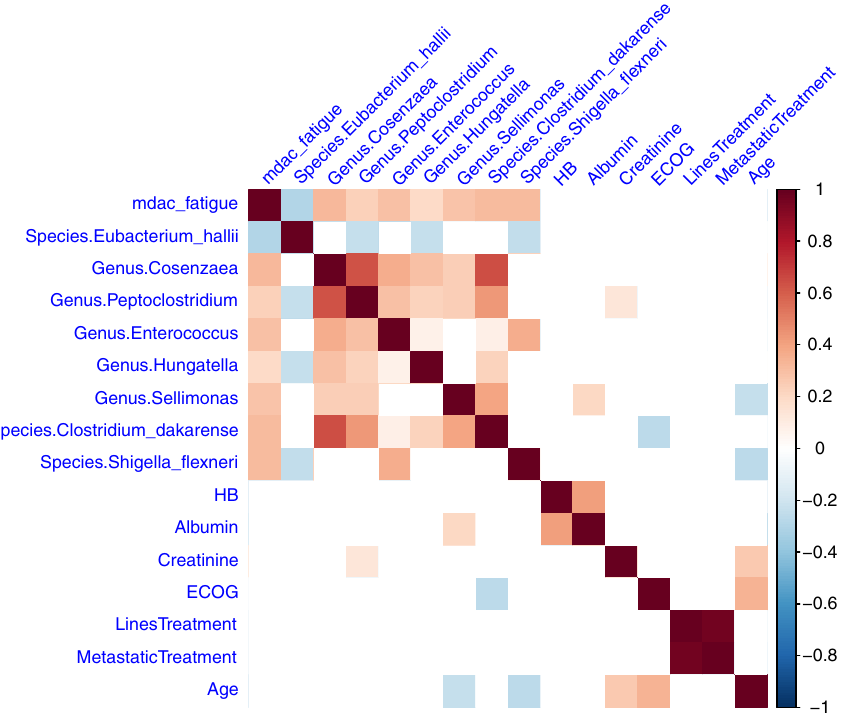
Figure 5. Results of the Spearman correlation analysis showing relationships among fatigue, selected microbiome species, and clinical measurements. The blue color indicates negative correlation while the red color indicates positive correlation. The depth of the color describes the strength of correlation. The absence of a color indicates a lack of no correlation (p-value >